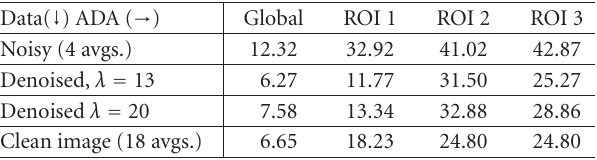
Table 2: The average deviation angle (ADA) of the noisy data, the processed data (two di ff erent regularization parameters), and the reference